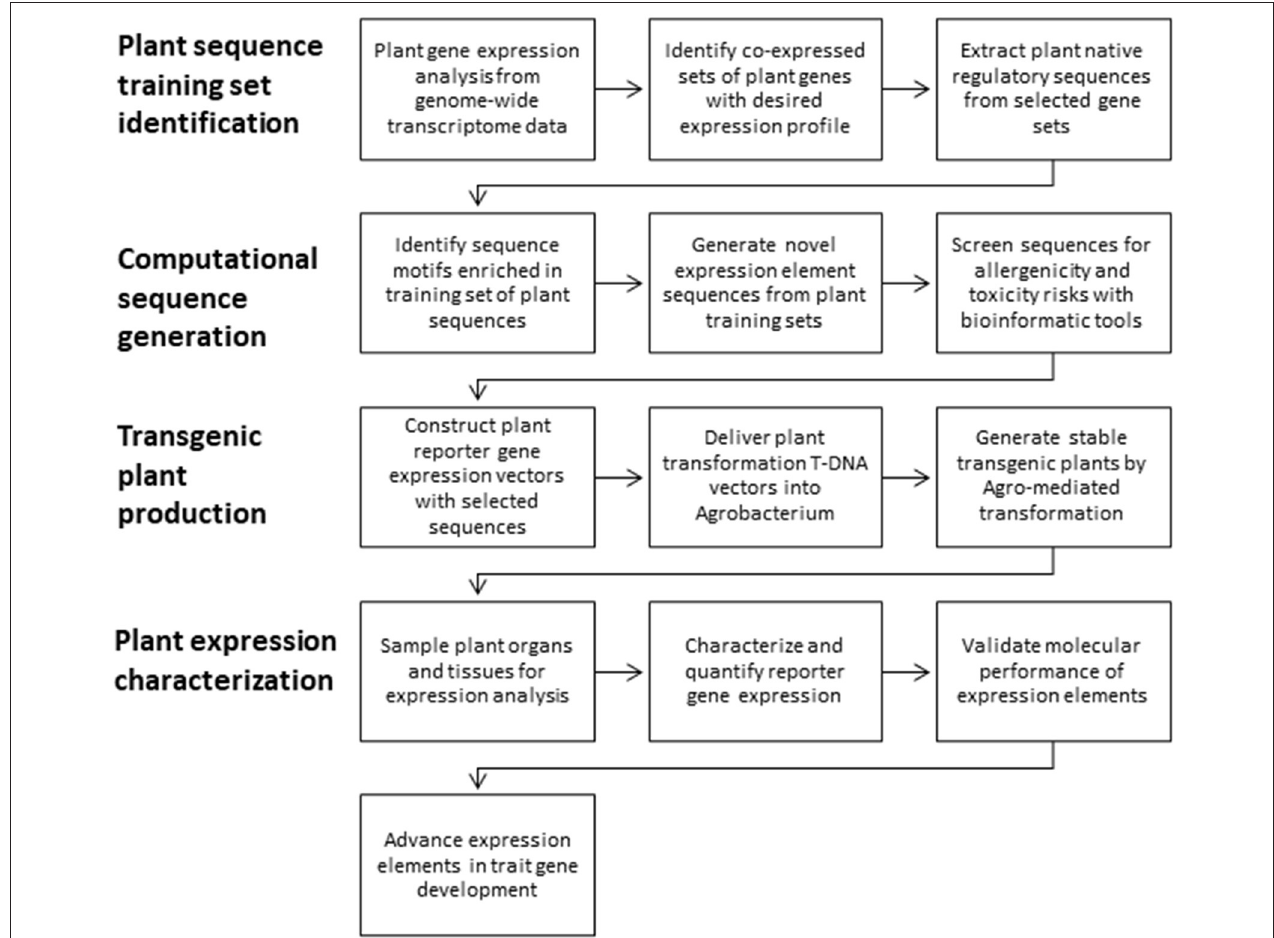
FIGURE 1 | Overview of expression element development and